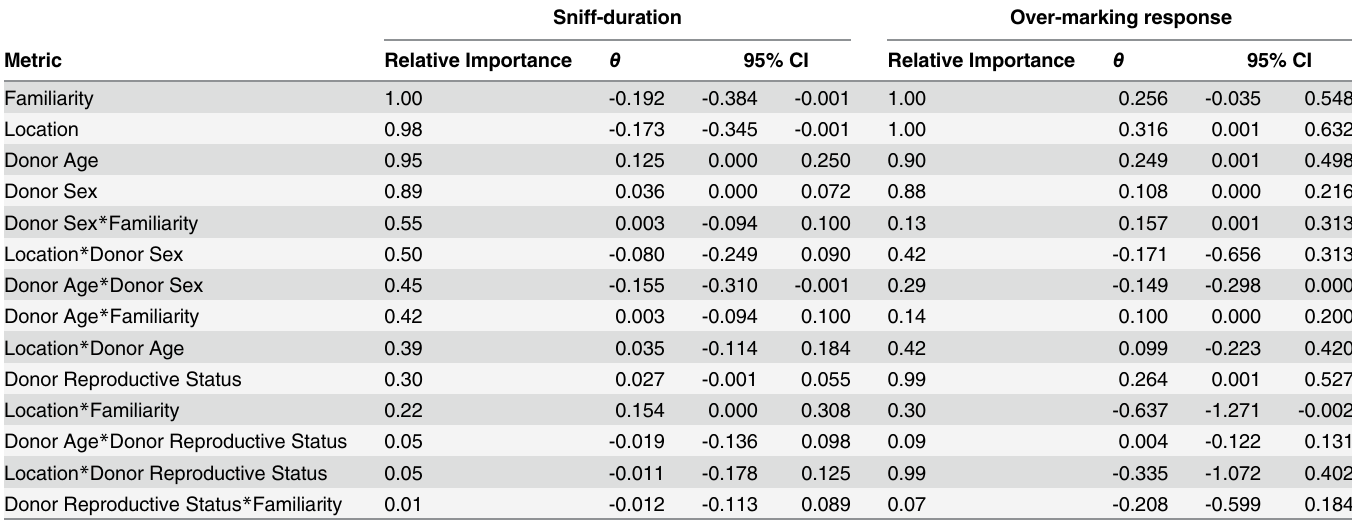
Table 3. Model averaging for the parameters linking sniffing and over-marking responses of badgers for a) the complete dataset ( n = 351). The Rel- ative Influence of each parameter (based on Akaike weights) is presented along with model-averaged estimated values of their coefficients ( θ ), and 95% con- fidence intervals